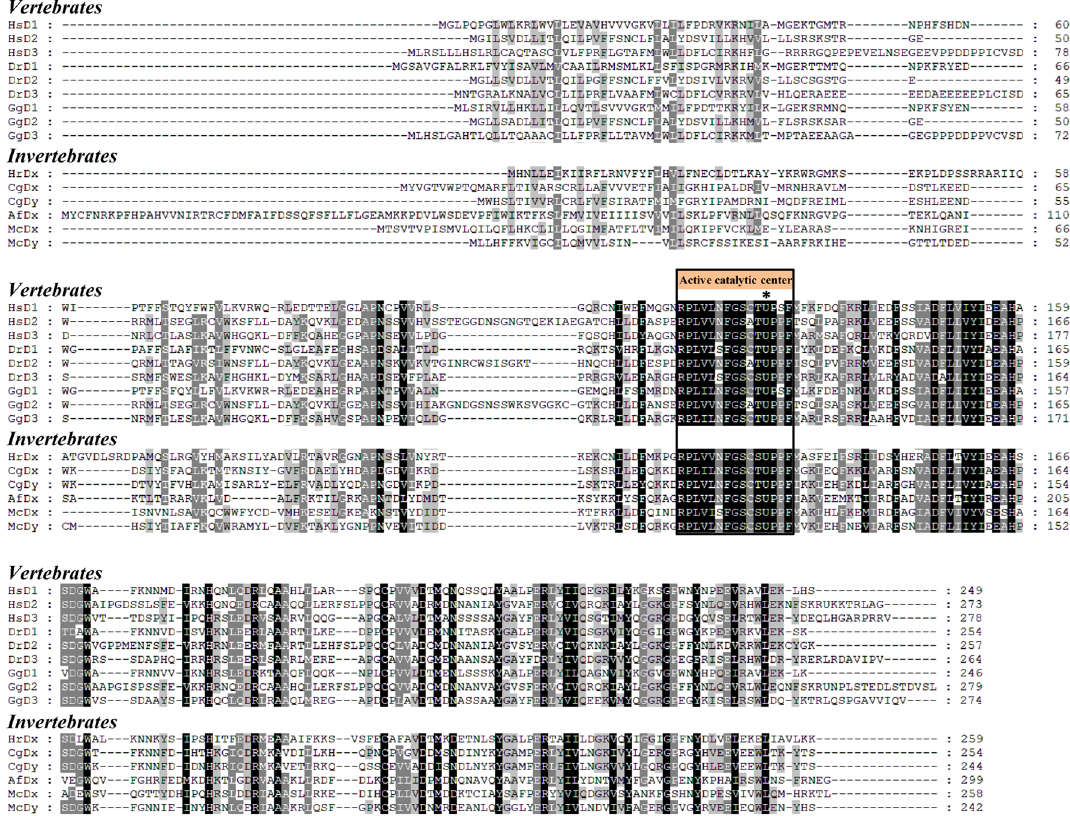
Figure 1. Multiple sequence alignment of two M. coruscus deiodinases with the deiodinases from vertebrates and invertebrates. The conserved active catalytic centers of the deduced amino acid sequences are indicated in orange. Identical amino acids are presented in black, similar amino acids in grey. An asterisk indicates a selenocysteine. HsD1 ( Homo sapiens , AAB23670), HsD2 ( H. sapiens , AAD45494), HsD3 ( H. sapiens , AAH17717), DrD1 ( Danio rerio , NP_001007284), DrD2 ( D. rerio , NP_997954), DrD3 ( D. rerio , NP_001242932), GgD1 ( G. gallus , NP_001091083), GgD2 ( G. gallus , AAD33251), GgD3 ( G. gallus , NP_001116120), HrDx ( Halocynthia roretzi , AAR25890), CgDx ( C. gigas AKF17655), CgDy ( C. gigas AKF17656), AfDx ( A. farreri , AEX08671), McDx ( M. coruscus , MW928627) and McDy ( M. coruscus ,